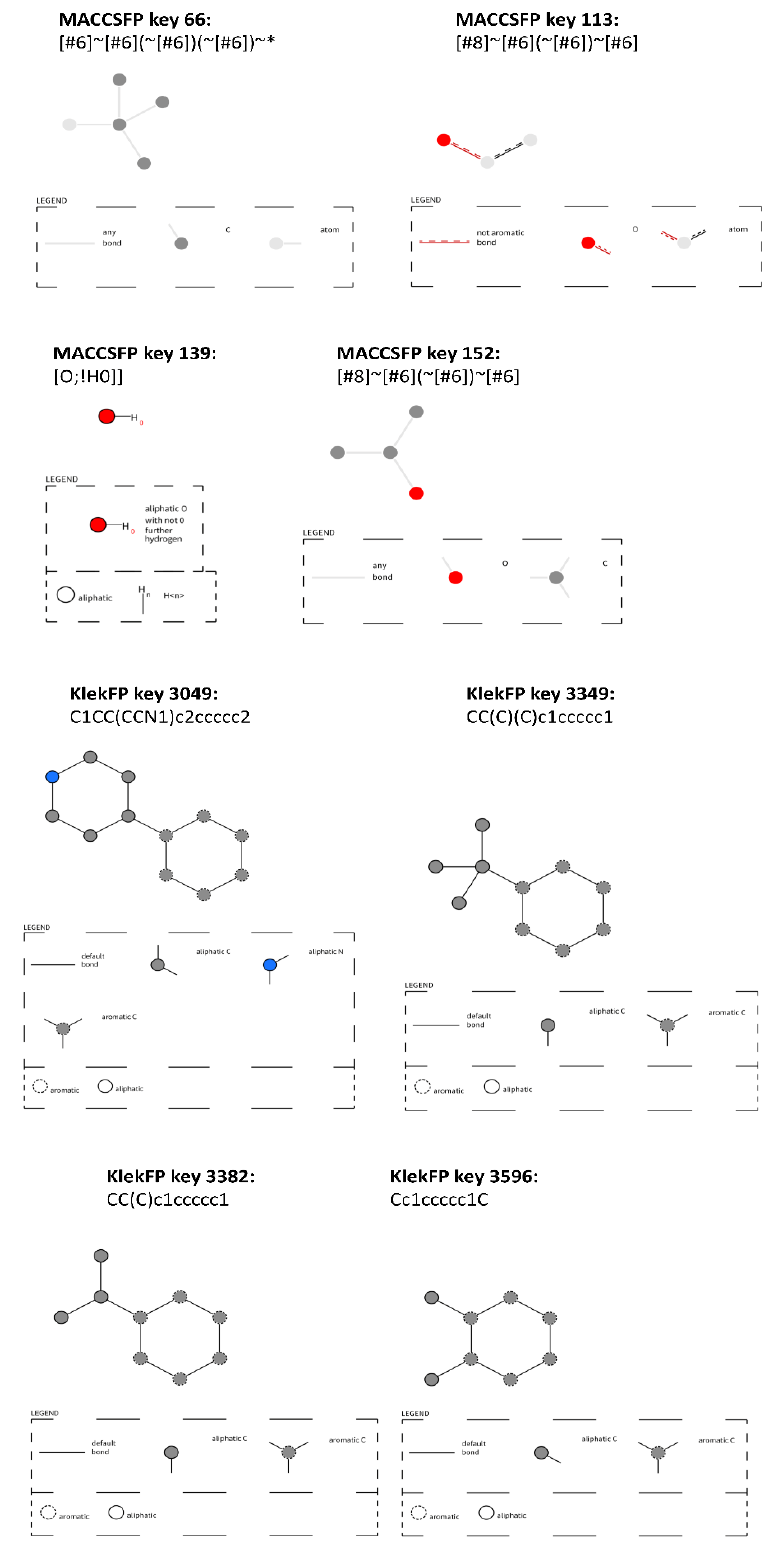
Figure 10. Keys with the highest difference in “on” bits common for all opioid targets considered. Visualized with the use of https://smarts.plus/ SMART.plus.co (accessed on 25 February 2021).